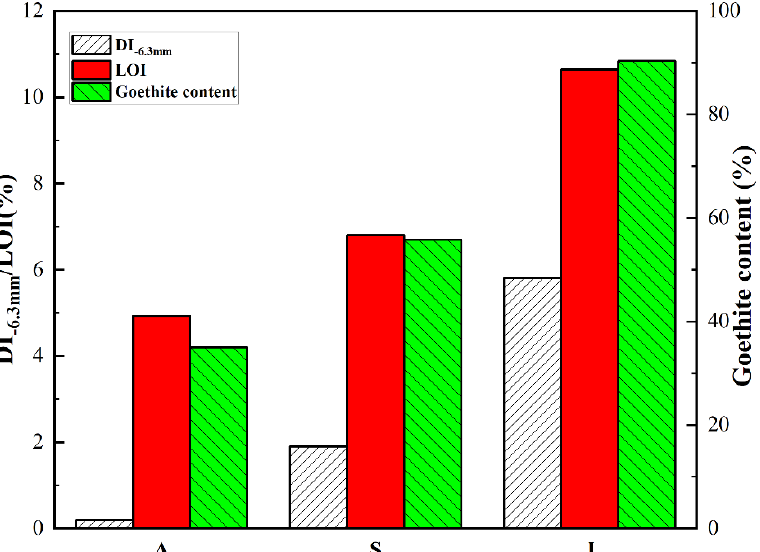
Figure 6. Relationship between fire waste and goethite content and decrepitation